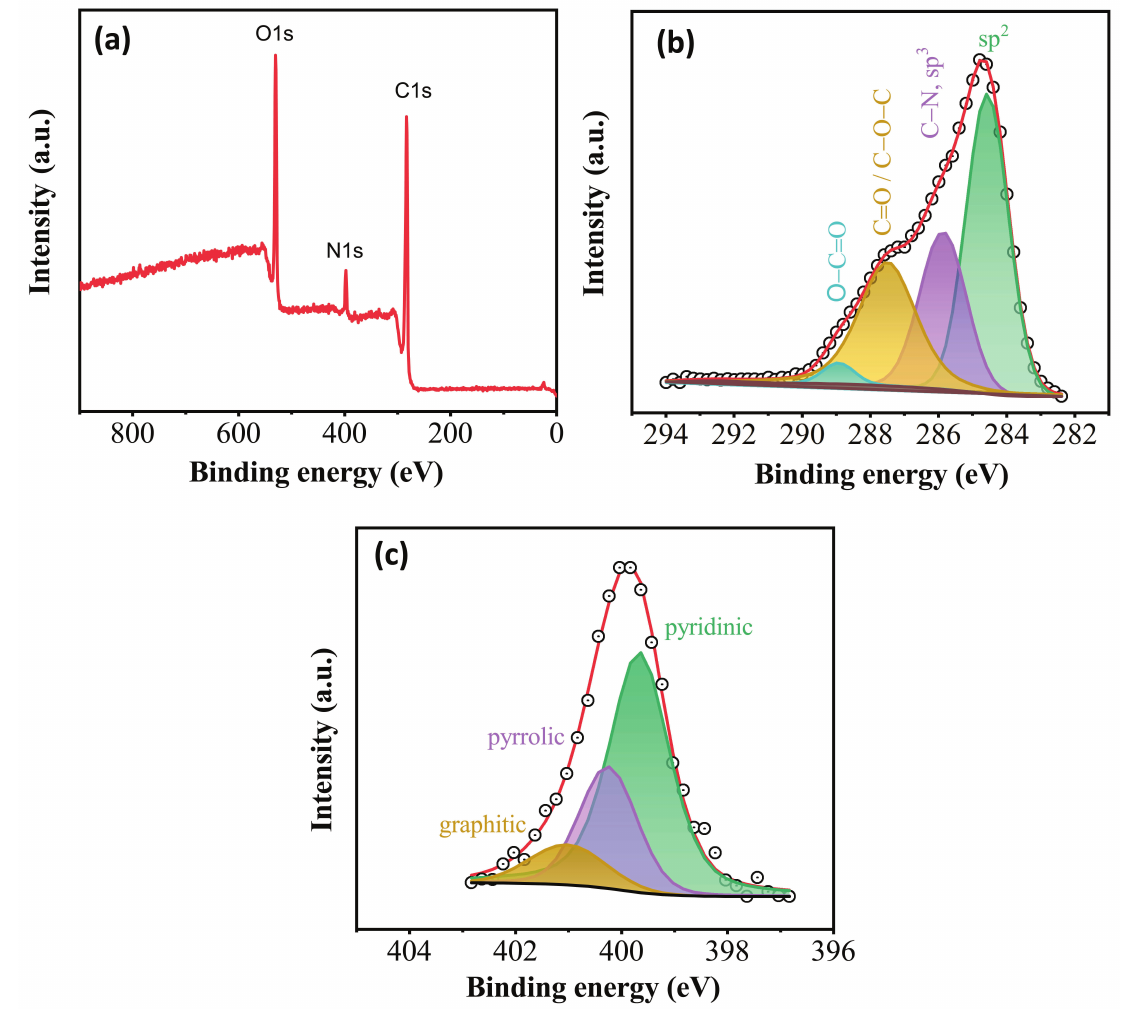
Figure 6. ( a ) X-ray photoelectron spectroscopy (XPS) survey spectrum of the sample. Deconvoluted high-resolution spectra of ( b ) C1s and ( c ) N1s